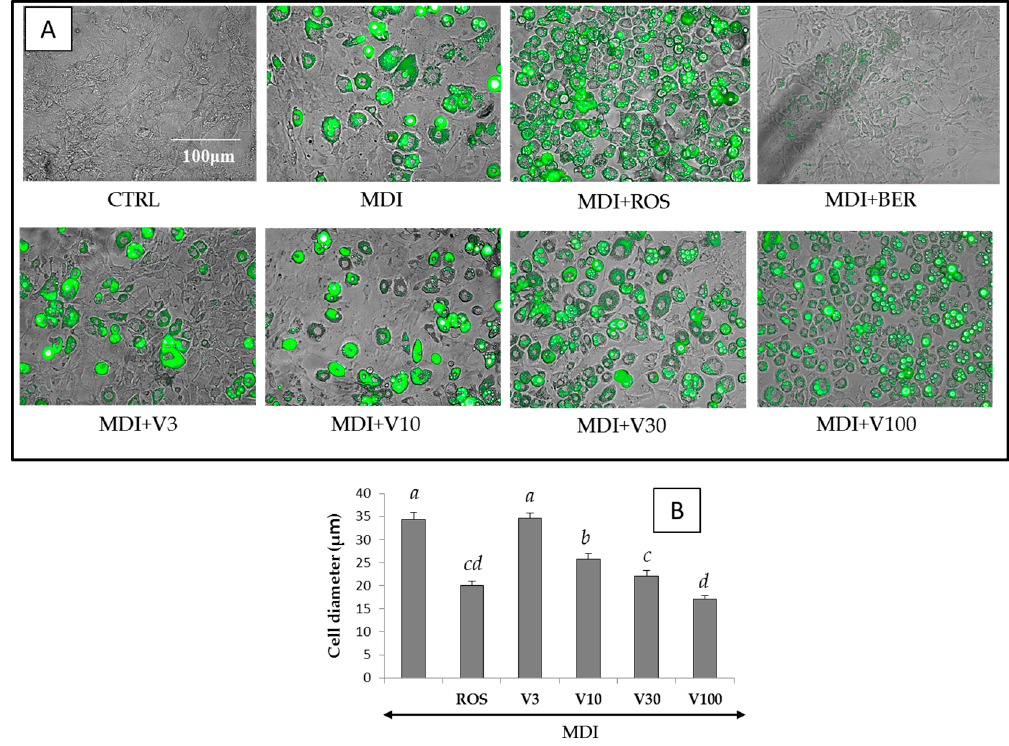
Figure 4. Merged phase differences and fluorescent images and the diameter of differentiated 3T3-L1 cells on day 8 with reference compounds or vitexilactone of various concentrations. The 3T3-L1 cells were cultured in 24-well plates and differentiated with DMI mixture and each compound under the conditions described in the Materials and Methods section. Fluorescent staining of intracellular lipids was accomplished by adding BODIPY 493/503 to the medium. Undifferentiated cells, cells with the addition of MDI (a mixture of 0.5 mM 3-isobutyl-1-methyl xanthine (M), 0.1 μ M dexamethasone (D), and 2 μ M insulin (I)), rosiglitazone, berberine, and vitexilactone are indicated by CTRL, MDI, ROS, BER, and V, respectively. ( A ) Cell diameters were determined using ImageJ. Data are presented as the mean ± SD from 100 cells of three independent pictures. The same letters indicate that there are no differences between those groups, and different letters indicate significant differences ( p < 0.05) ( B ).